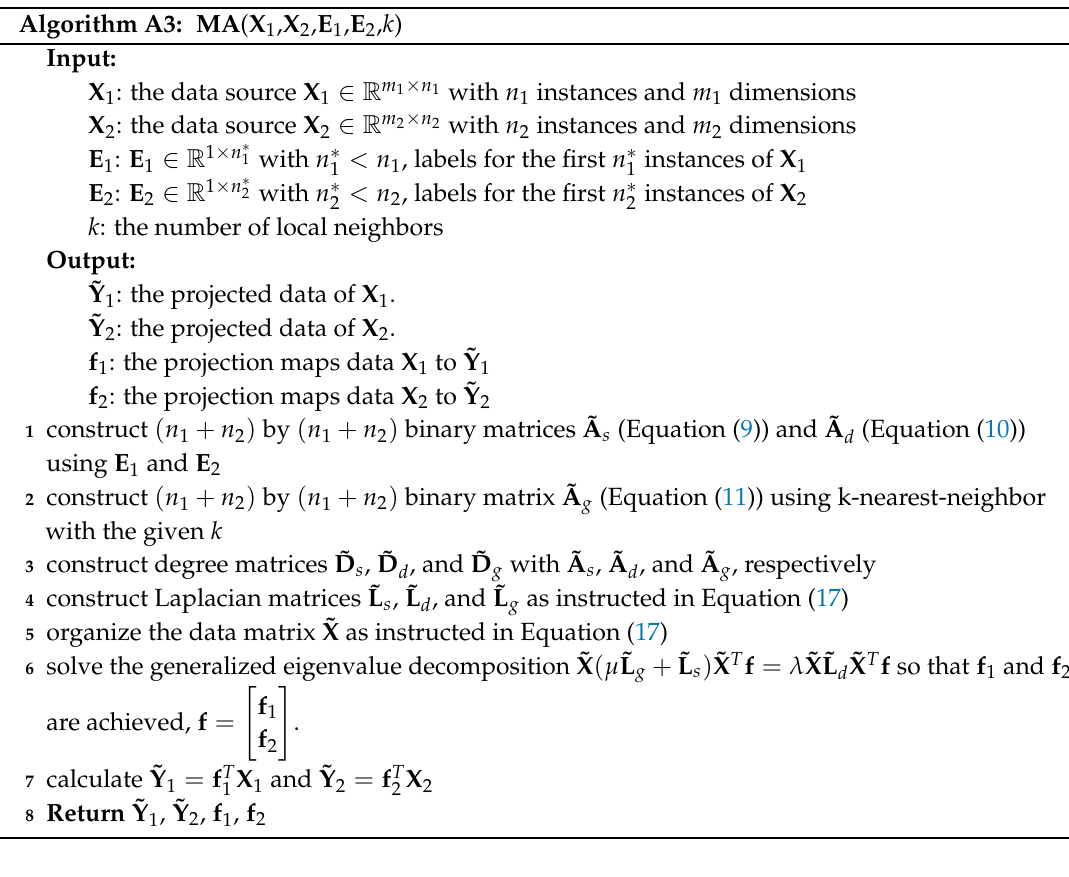
Algorithm A3: MA ( X 1 , X 2 , E 1 , E 2 , k )